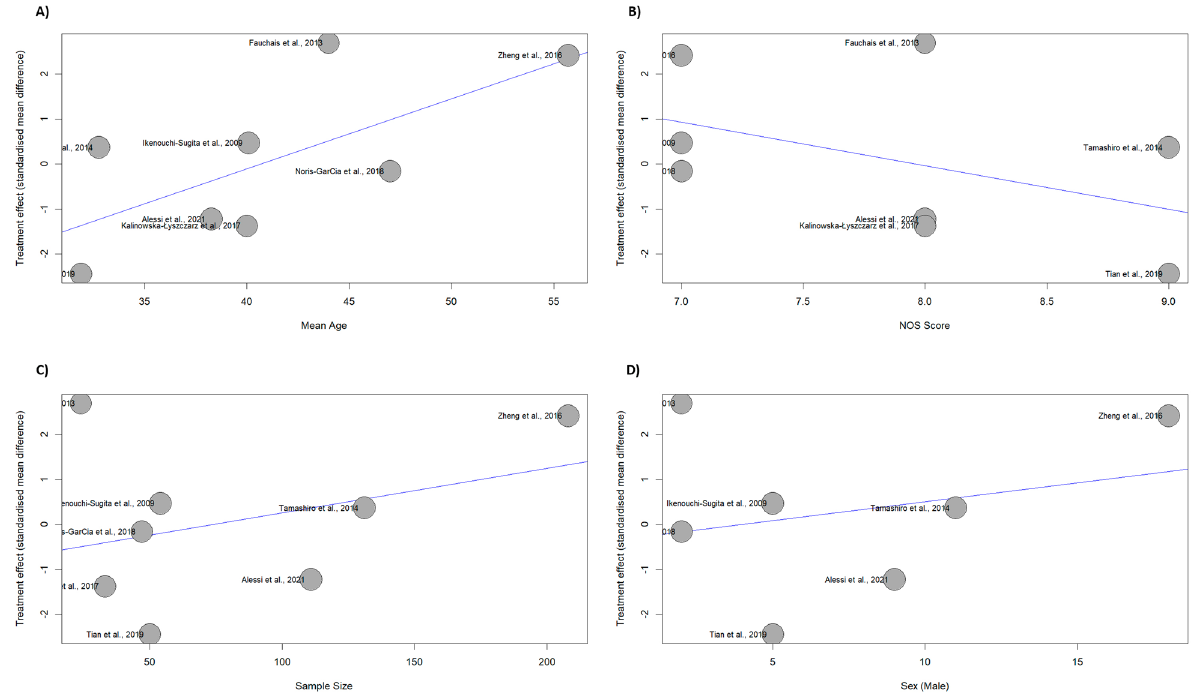
Fig. 5 Bubble plot of meta-regression A Mean Age; B NOS Score; C Sample Size; D Sex